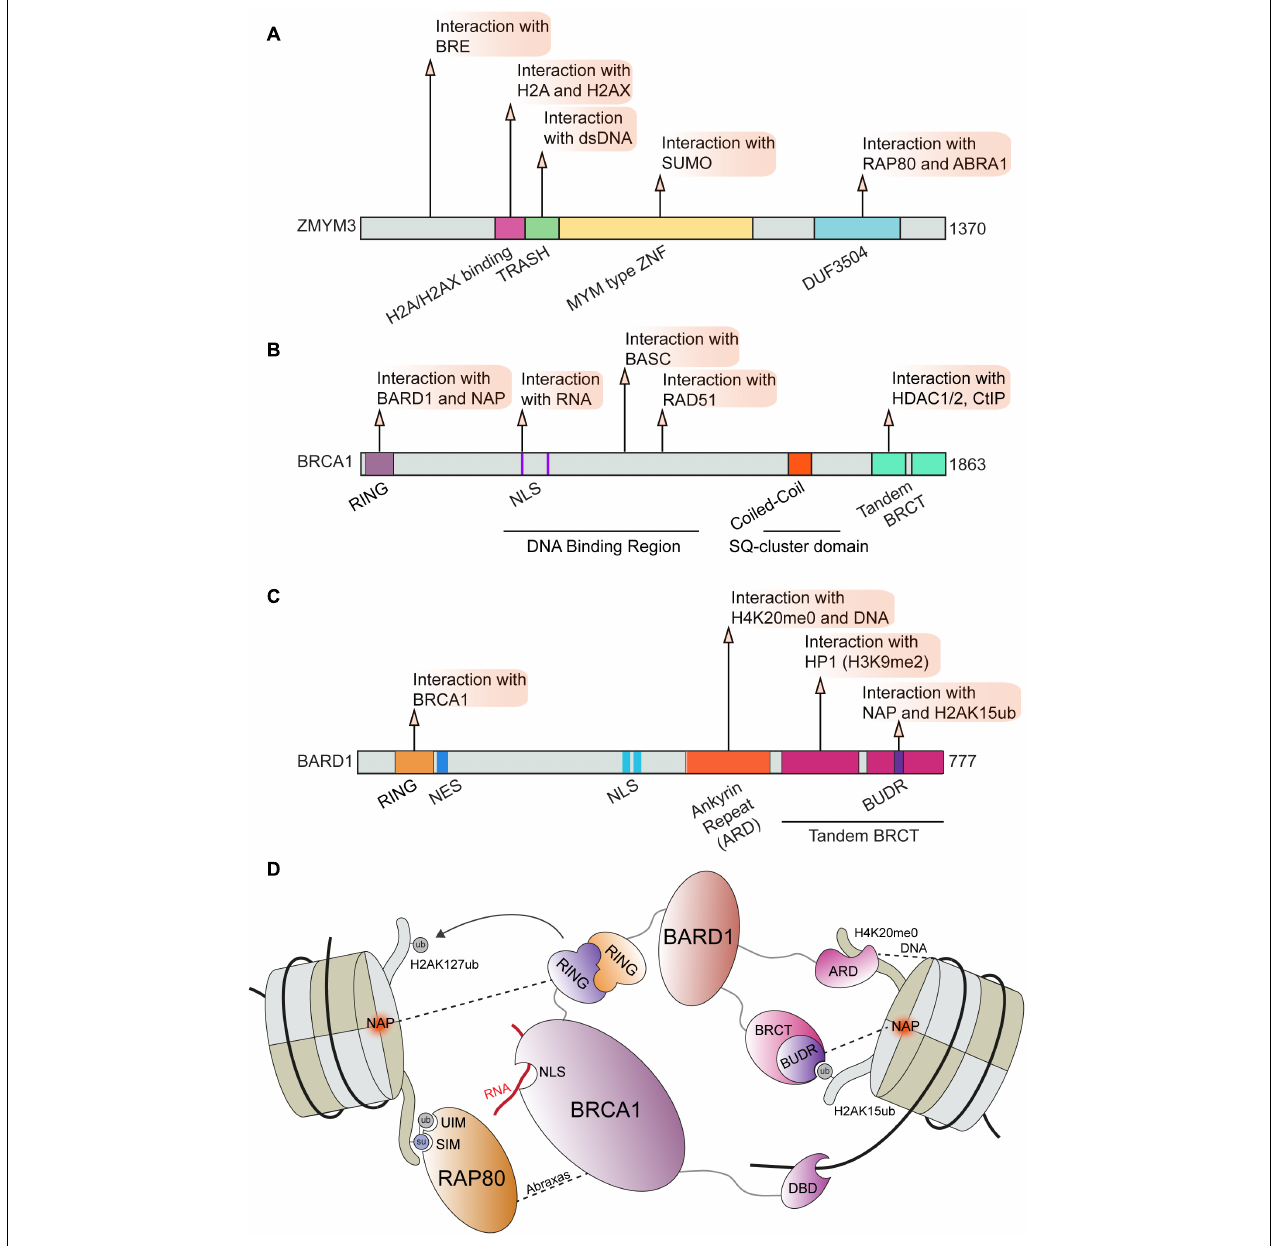
FIGURE 3 | BRCA1 and associated factors in DNA repair. Domain map and DDR interactions of (A) ZMYM3; (B) BRCA1; and (C) BARD1. (D) Schematic of interactions between the BRCA1-BARD1 complex and chromatin that facilitate BRCA1 mediated DNA repair. BRCA1 can directly bind to RNA via its NLS region and to DNA via its DBD. BRCA1 binding to BARD1 through its RING domain and association with RAP80 through direct interactions with Abraxas are essential for BRCA1 function during DDR. BARD1 and RAP80 interact directly with several chromatin marks and serve to correctly position this complex at damage sites. BRE, Brain and Reproductive Organ-Expressed; RAP80, Receptor-Associated Protein 80; ABRA1, Abraxas; TRASH, Trafficking, Resistance, And Sensing Heavy Metals Domain; MYM, MYeloproliferative and Mental Retardation; DUF3504, Domain of Unknown Function; BASC, BRCA1-associated genome surveillance complex; HDAC1/2, Histone Deacetylase 1/2; CtIP, CtBP-interacting protein; RING, Really Interesting New Gene; NLS, Nuclear Localization Sequence; BRCT, BRCA1 C-terminus domain; NES, Nuclear Export Sequence; HP1, Heterochromatin Protein 1; BUDR, BARD1 ubiquitin (Ub)-dependent recruitment and BRCT-associated ubiquitin-dependent recruitment; NAP, Nucleosome Acidic Patch; UIM, Ubiquitin Interacting Motif; SIM, SUMO Interacting Motif; DBD, DNA Binding Domain.